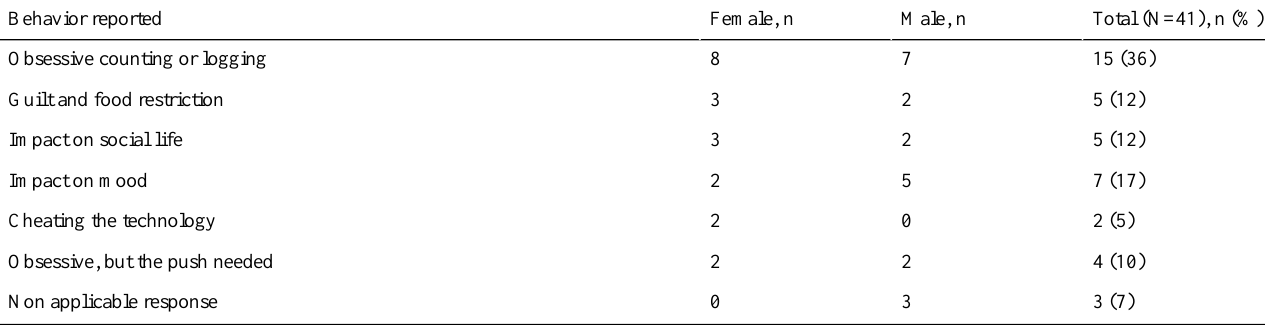
Table 3. Reports of negative or obsessive app use behaviors from